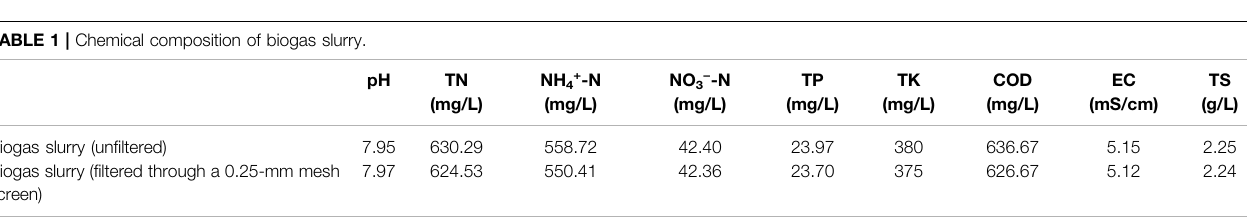
TABLE 1 | Chemical composition of biogas